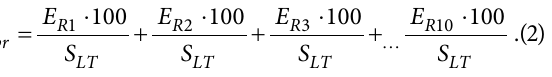
Table 3. Simulation of solar radiation on the surfaces of different types of pigeon towers